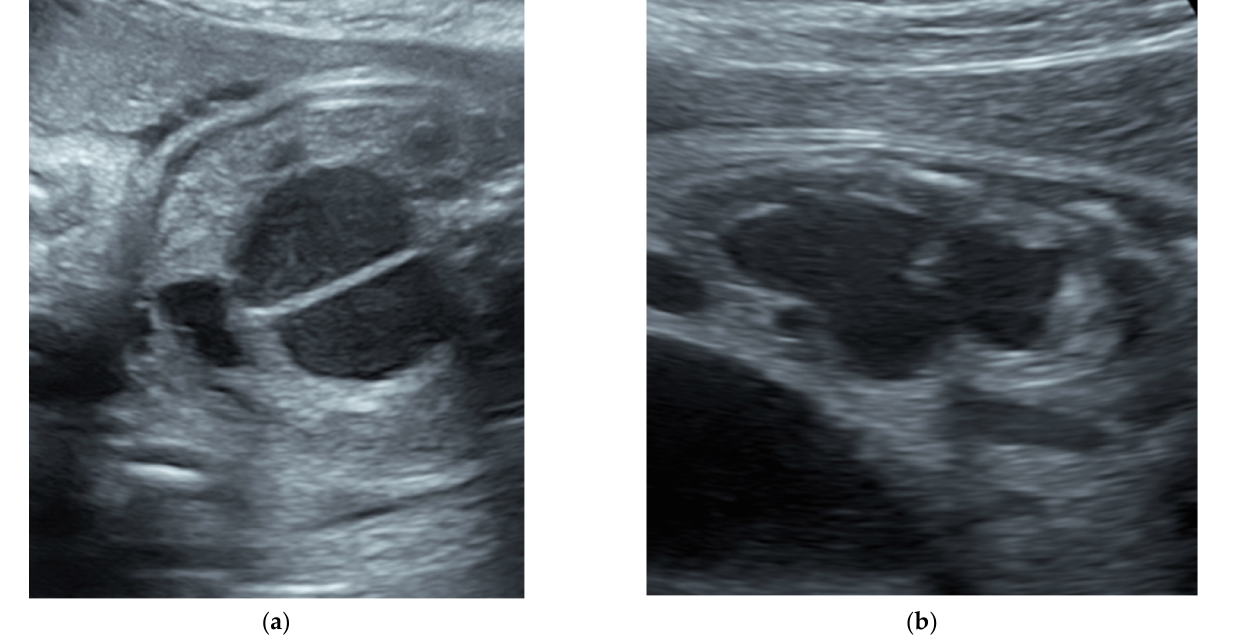
Figure 1. Fetal ultrasounds show: ( a ) hydrocolpos with longitudinal vaginal septum, and ( b ) hydro ‐